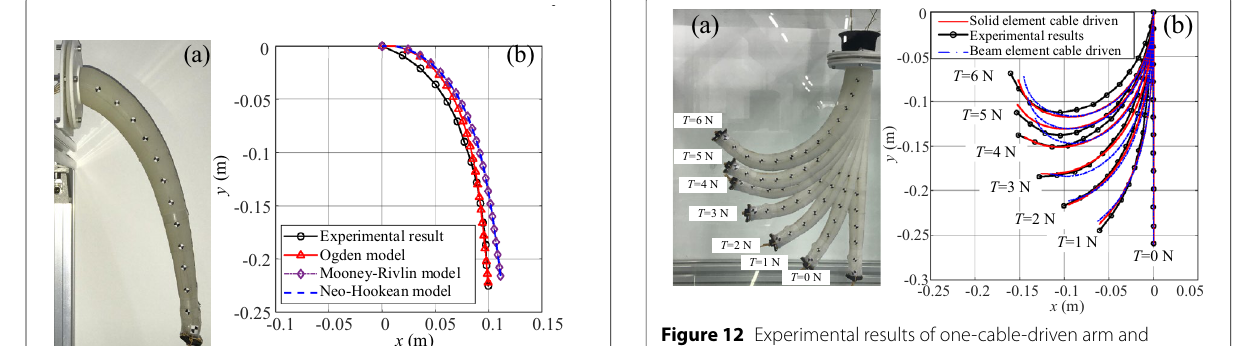
Figure 12 Experimental results of one-cable-driven arm and comparison with simulation